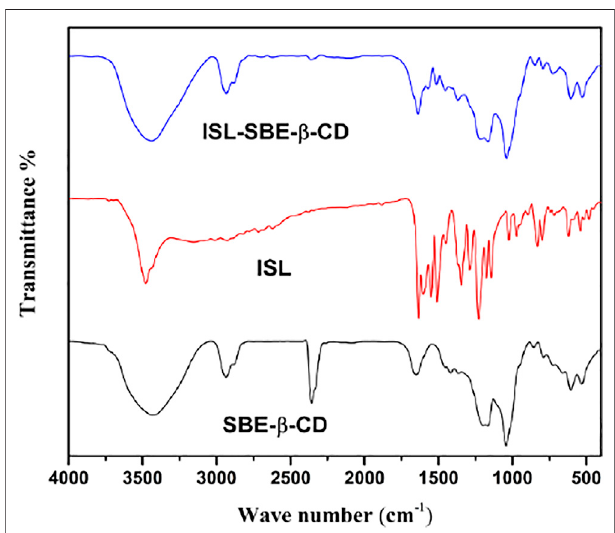
FIGURE 3 | FT-IR spectra of ISL, SBE- β -CD, and ISL-SBE- β -CD.